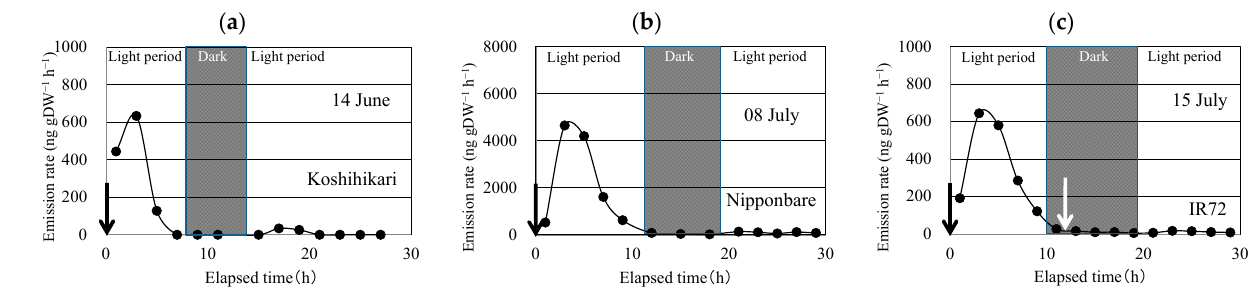
Table 1. Range of maximum emission rates of linalool observed after enclosing rice leaves and stems with the enclosure bag.